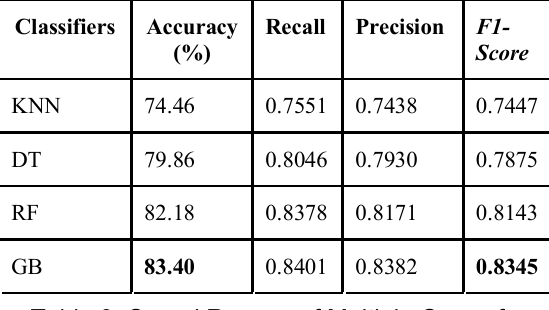
Figure 8. Obtained Accuracy for all classification algorithms. Table 8. Comparison of KNN, DT, RF and GB algorithms on test data set in terms of Accuracy, Precision, Recall and F1-Score